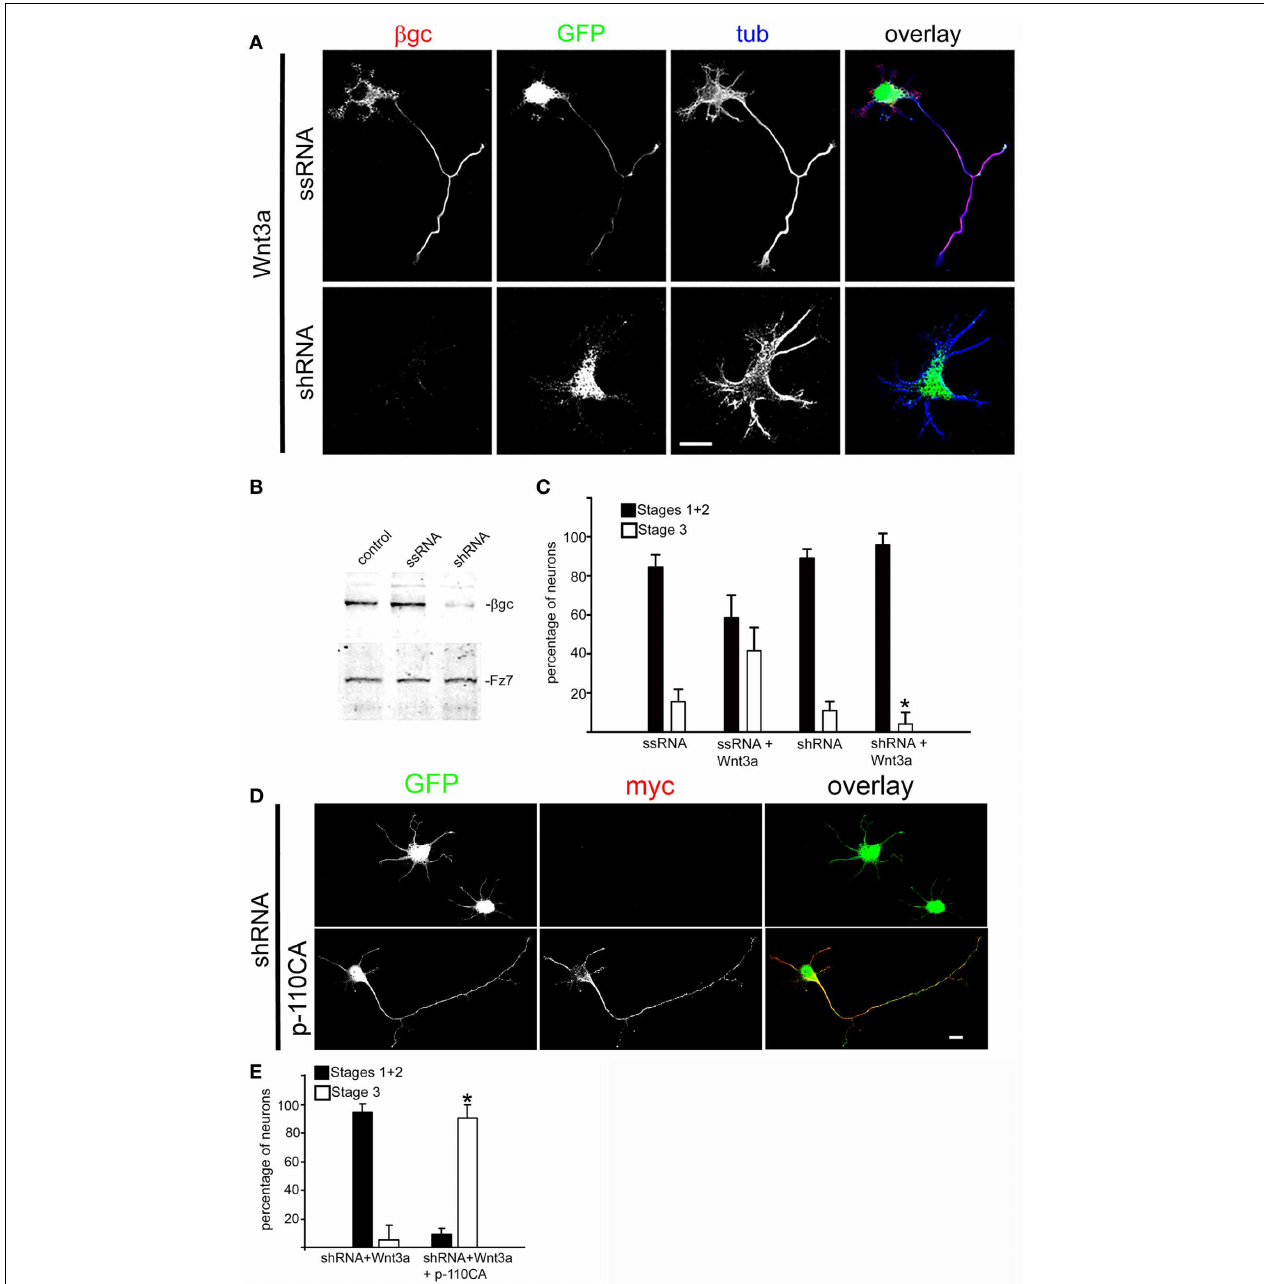
FIGURE 4 | Wnt3a polarizing effects required normal expression of IGF-1r. (A) Triple immunofluorescence micrographs of hippocampal neurons after 24h in culture showing the distribution of the IGF-1r β gc subunit, a scrambled sequence RNA (GFP, top) or IGF-1r targeted shRNA (GFP, bottom), and the neuronal marker β -III tubulin (tub). Cells were cultured in medium containing 1.35nM Wnt3a. The ssRNA transfected cells (top) showed a normal morphology. In contrast, the shRNA transfected cells (bottom) did not develop an axon. (B) Western blots showing protein levels of β gc, the Wnt receptor Fz7 (to control specificity, also serves as loading control) and cells transfected with a scrambled RNA sequence (ssRNA), and cells transfected with IGF-1r shRNA (shRNA). We observed a substantial decrease in β gc expression in the shRNA treated cells. (C) Percentage ( ± sem) of neurons at different specific stages of differentiation grown for 20h in culture in control medium or in the presence of 1.35nM Wnt3a and transfected with a